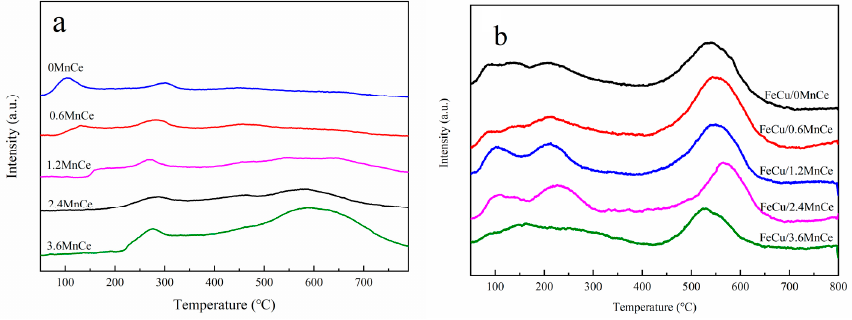
Figure 2. CO-TPD profiles: ( a ) supports, ( b ) fresh catalysts.